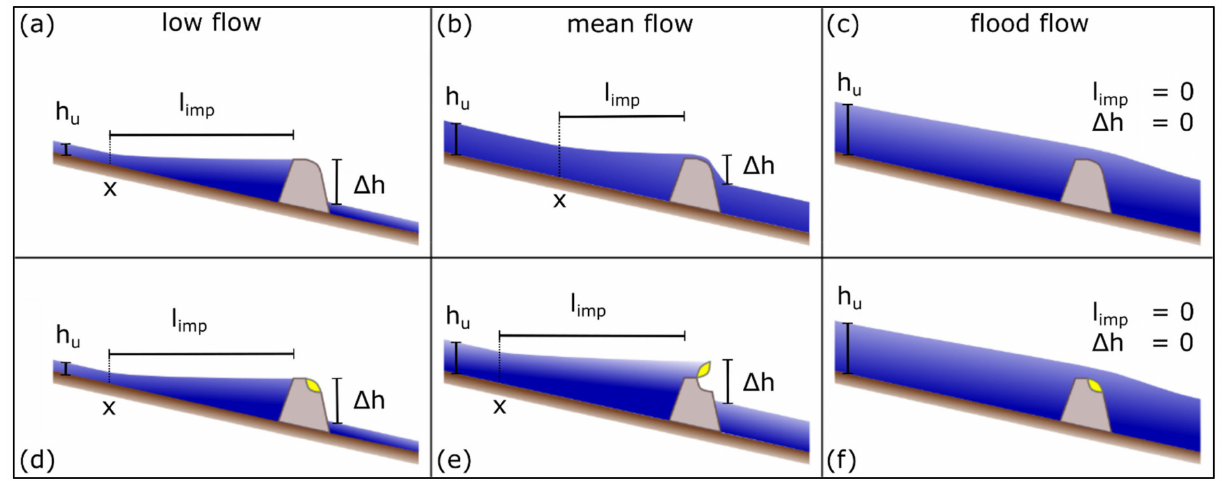
Figure 1. Principle sketch of static ( a – c ) and dynamic water-level regulation ( d – f )